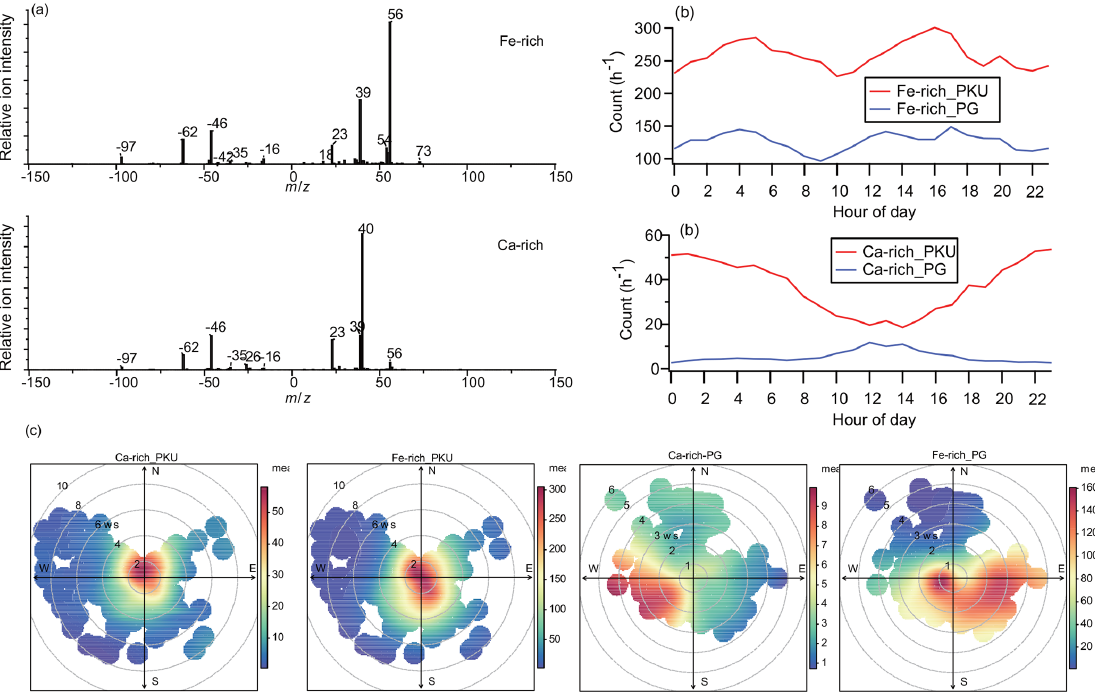
Figure 7. (a) Average mass spectra of Fe-rich and Ca-rich observed at both sites; (b) diurnal patterns of the hourly count of Fe-rich and Ca-rich types at both sites; (c) polar plots of Fe-rich and Ca-rich types; the gray circles indicate wind speed (ms 1